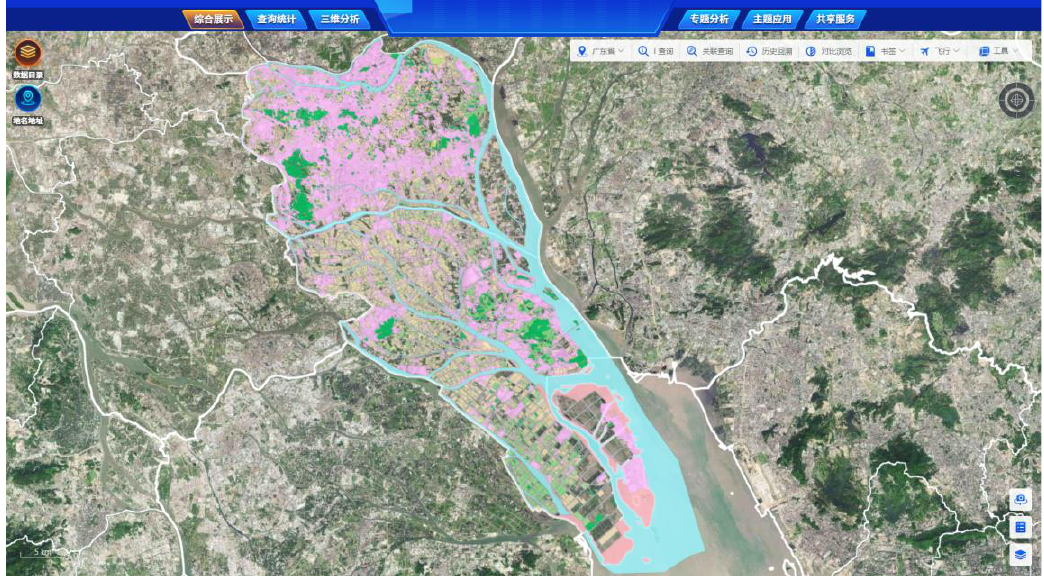
Figure 11. The land use in the study area is shown in the NRIDB.